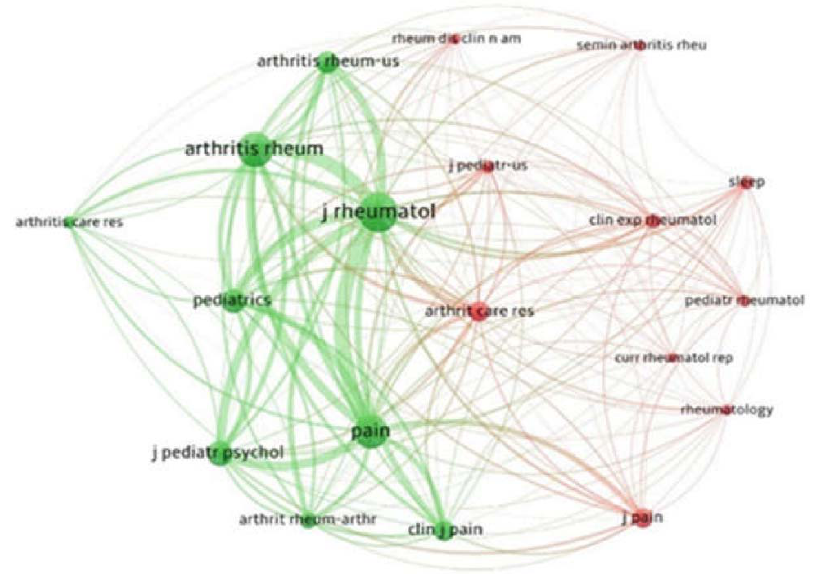
Figure 5. Co-citation analysis for sources. The lowest number of citations for a source was n = 17. Of the 597 sources, 19 satisfied the threshold.